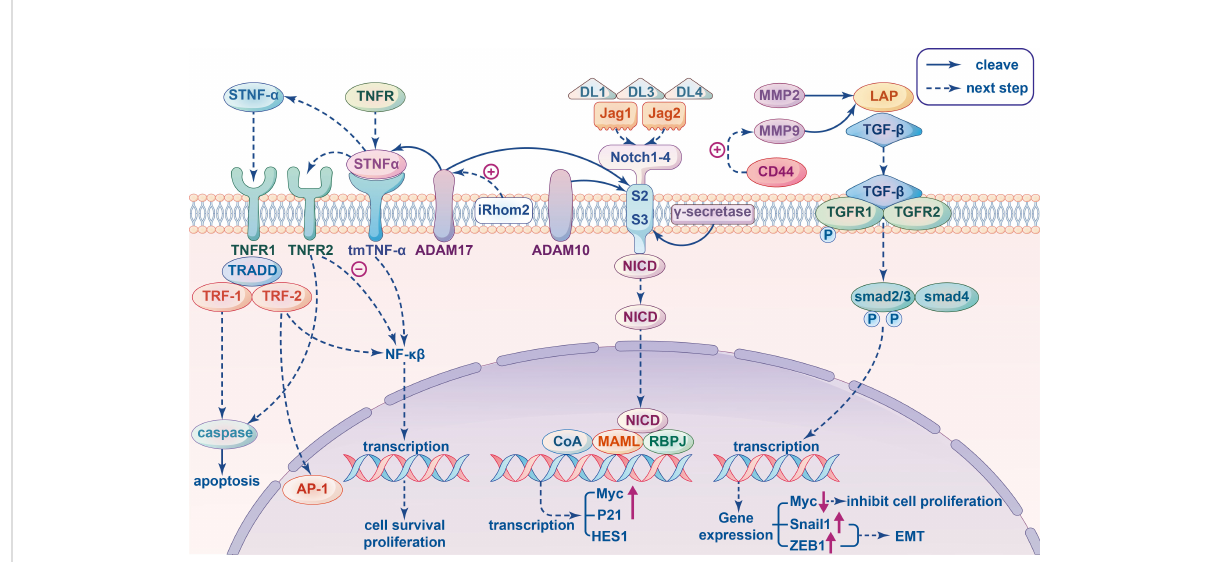
FIGURE 2 Signal pathway involving metalloproteinases related to immunity in cancer cells. Tumor Necrosis Factor (TNF) signal pathway: The transmembrane TNF- a (tmTNF- a ) cleaved by proteolytic enzyme ADAM17 produced soluble TNF- a (sTNF- a ), which binds to TNFR1 and then recruits TNFR-associated death domain (TRADD), TNFR-associated factor (TRF)-1 and TRF-2 generating two different results: mediating caspase activation to apoptosis or leading to activation of the NF- k B and AP-1 for tumor cell proliferation. When tmTNF- a binds to TNFR2 as ligands to inhibite NF- k B mediated activation of anti-apoptotic genes, then apoptosis and tumor suppression will be triggered; as a receptor tmTNF- a transect the reverse signal to promote tumor proliferation by constitutively activating NF- k B. The activity of ADAM17 can be stimulate by pseudoprotease enzyme iRhom2. Transforming growth factor b (TGF- b ) signal pathway: MMP9 and MMP2 cleave the inactive latent TGF- b propeptide (LAP) and produce different activated TGF- b proteolytic cleavage products. In the canonical pathway, active TGF- b triggers TGF b RII to phosphorylate TGF b RI, which in turn recognizes and phosphorylate SMAD2 and SMAD3 proteins to interact with SMAD4 to form a complex that can enter the nucleus and regulate the transcription of target genes. For example, down-regulating the expression of proto-oncogene Myc to inhibit cell proliferation, inducing the Snail1 and ZEB1 to promote epithelial mesenchymal transition (EMT) in tumors. The co-aggregation of CD44 and MMP9 can promoted the protein activity of MMP9. Notch signaling pathway: ADAM10 and ADAM17 have been indicated in many studies that they can act on cleaving S2, and subsequent cleavage S3 mediated by g -secretase occurs in the transmembrane region, leading to the release of Notch intracellular domain (NICD), which translocate into the nucleus and combines Mastermind-like (MAML) and DNA-binding protein Recombination Signal-binding Protein for Immunoglobulin kappa J region (RBPJ) to recruits additional coactivators (CoA) triggering the transcription of target genes, such as Myc, P21, HES1 and so